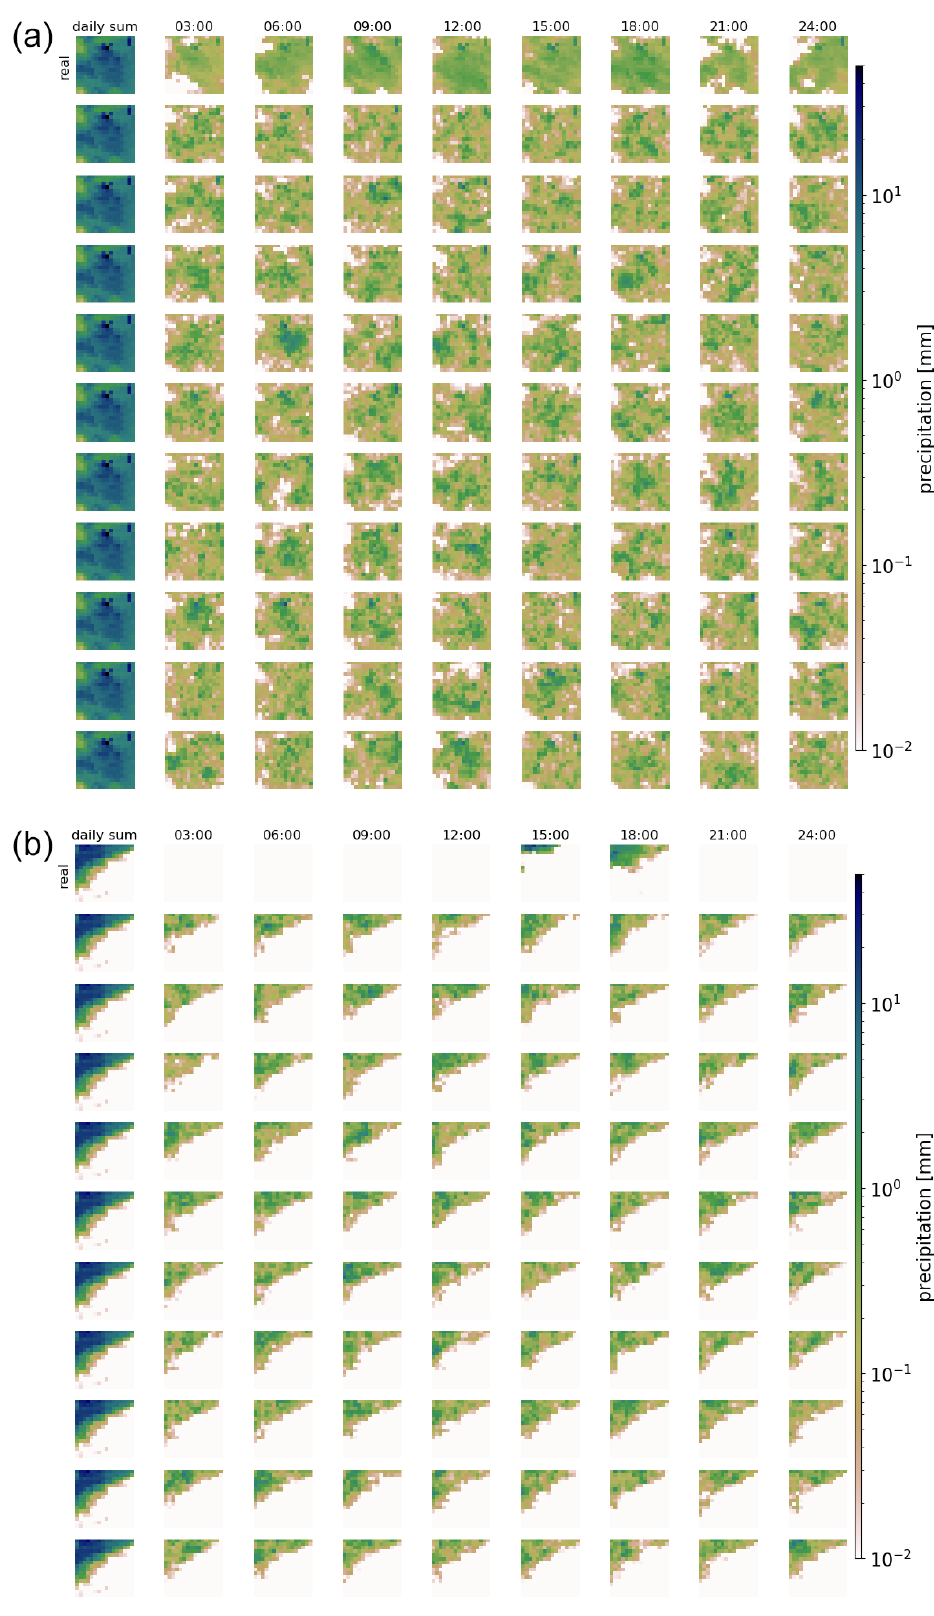
Figure 5. Patterns generated with the RainFARM baseline algorithm, for the same days as in Figs. 3 and 4.